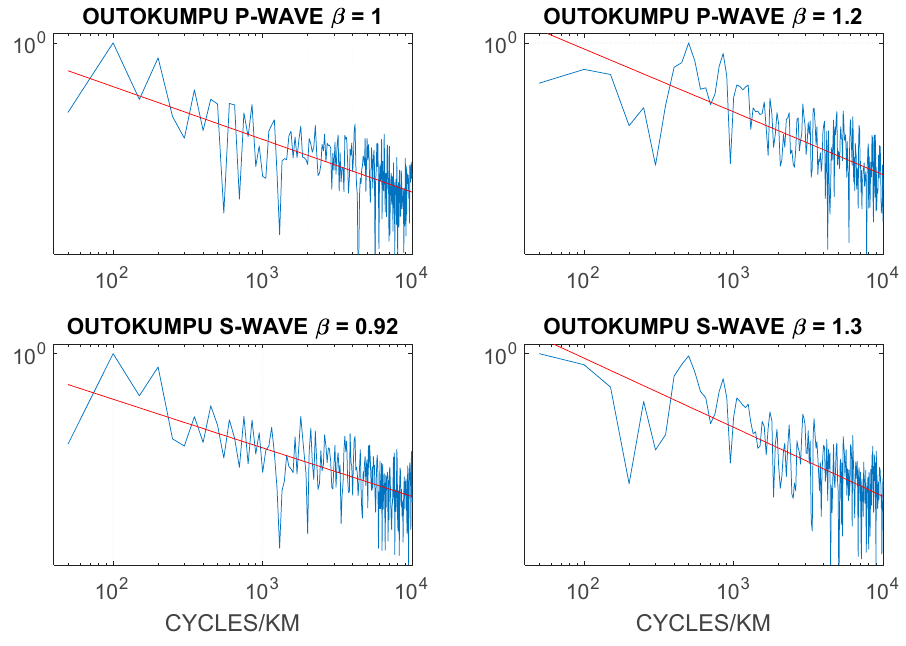
Figure 23. Sample Outokumpu well-log sonic-velocity spectral scaling S(k) ~ k β , β ~ 1.2 ± 0; depths 950–1500 m and 1900–2500 m [28].